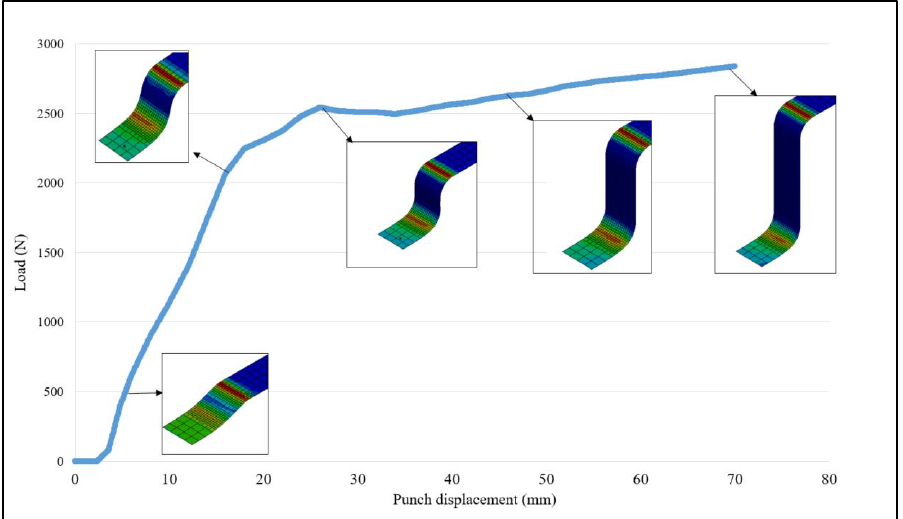
Figure 27. Stages of U-channel drawing along the punch load vs. displacement curve for the 0.2/0.8/0.2 mm sandwich laminate.